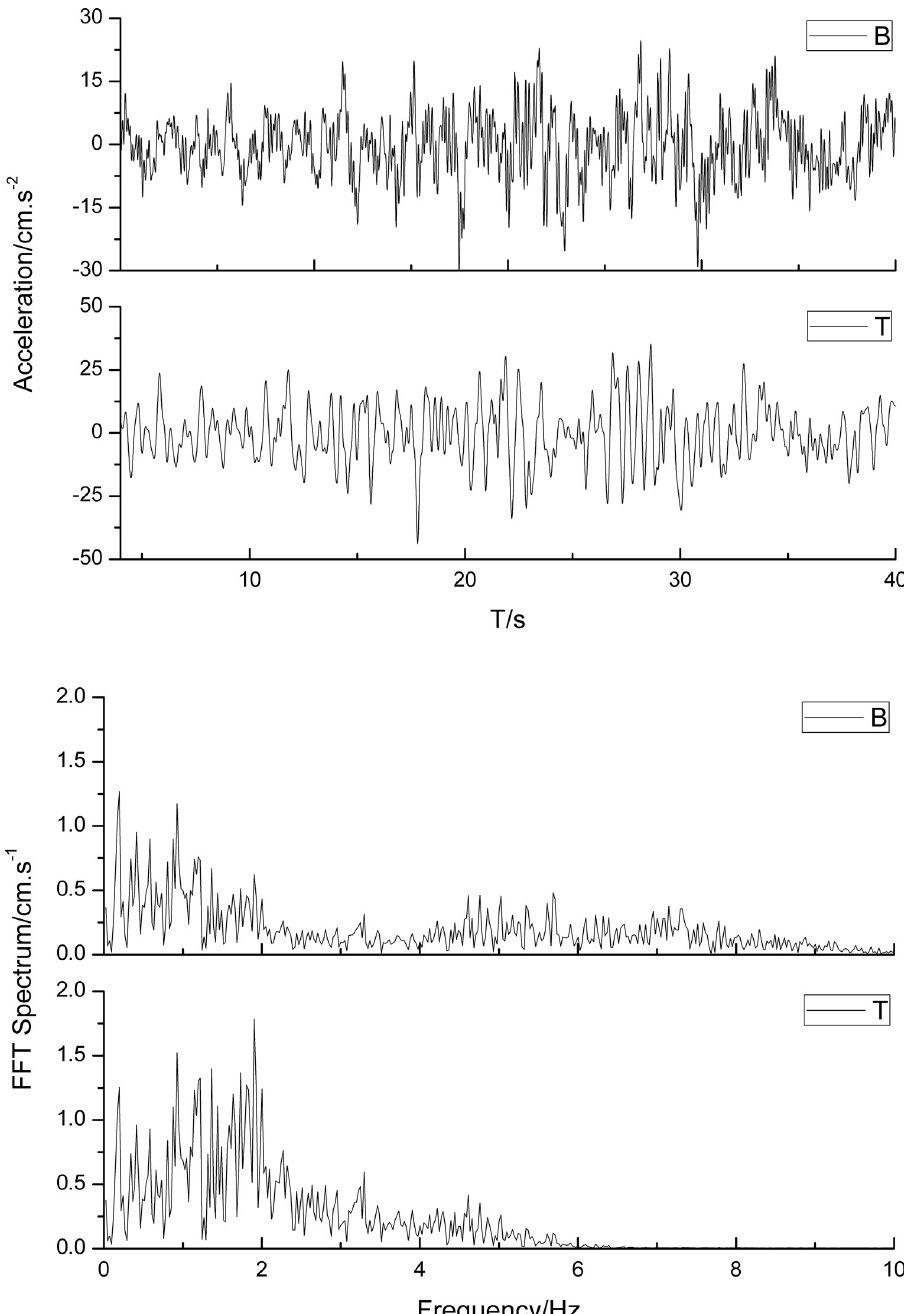
Fig 10. The acceleration time histories and the spectrum characteristics of different observation points. (a) the acceleration time histories; (b) the spectrum characteristics.